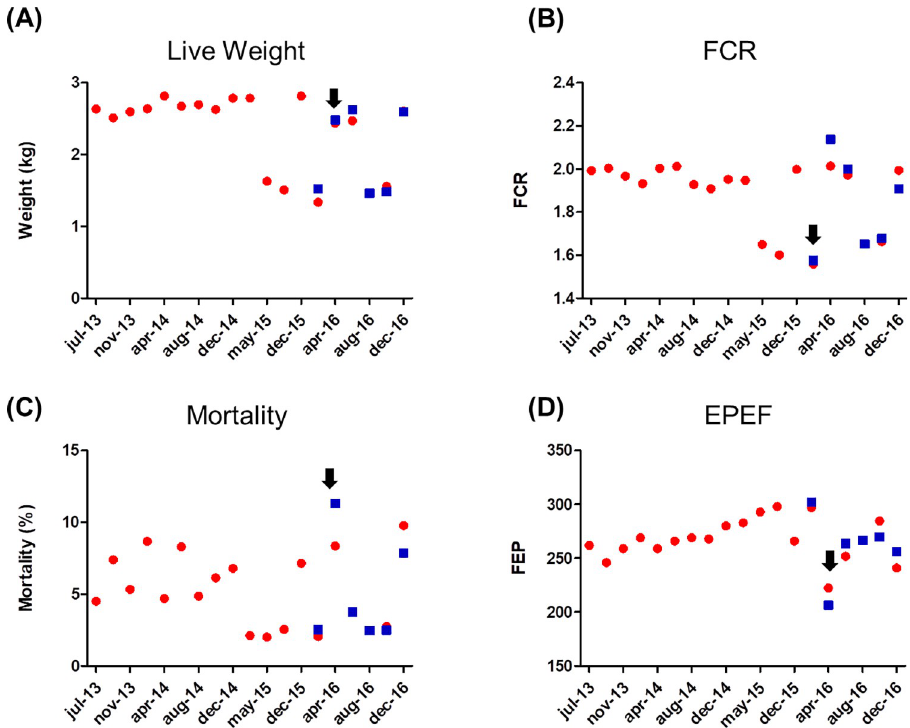
Fig 3. Productive historical records and results from experiment 2. A) Live body weight at the end of the productive cycle; B) Feed conversion ratio (FCR); C) Mortality; and D) European Poultry Efficiency Factor (EPEF). The period included in the present study starts from December 2015 (dec-15) to December 2016 (dec-16); red dots represent data from flocks under AGPs program and include data from previous productive cycles; blue squares represent data from AGPs free/tannins based program. Black arrow indicates the occurrence of a respiratory disease